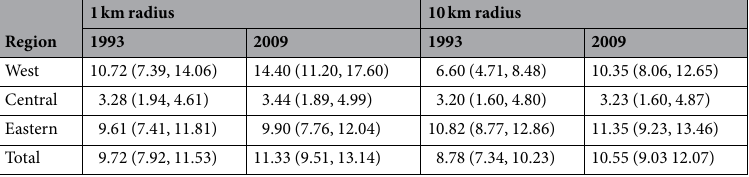
Table 2. Human footprint indices (mean and 90% CI) in 1993 and 2009 at 1 km and 10 km radii around MAPS stations in west, central and eastern regions of the Canada warbler breeding range. Values of the Human Footprint Index range from 0 (no footprint) to 50 (high footprint).